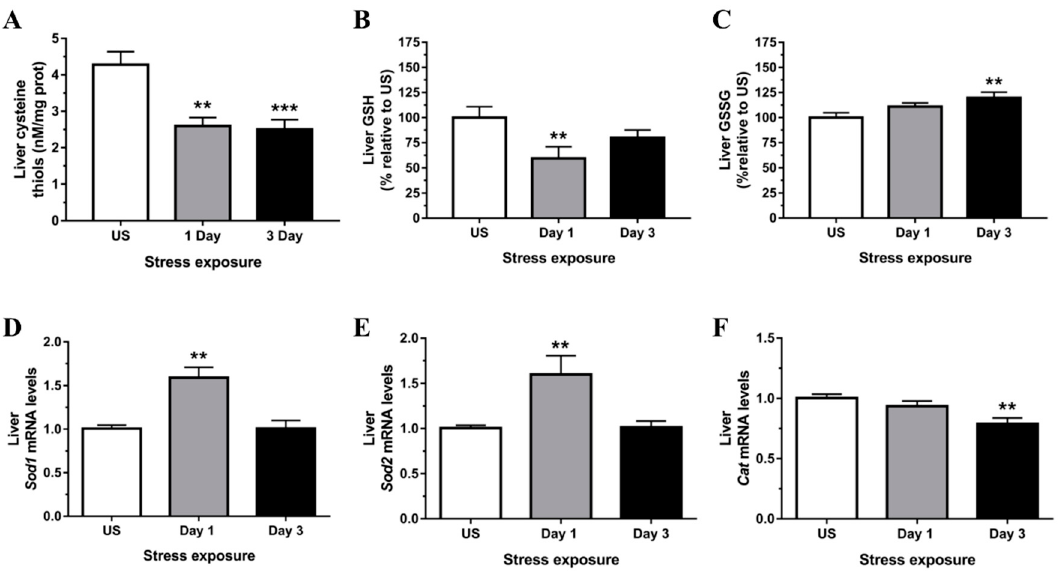
Figure 2. Restraint stress induces hepatic redox imbalance as shown by ( A ) decreased free cysteine thiol content and ( B ) decreased reduced glutathione (GSH) with increased ( C ) glutathione disulfide (GSSG). This occurs alongside increased mRNA expression of ( D ) superoxide dismutase 1 ( Sod1 ) and ( E ) superoxide dismutase 2 ( Sod2 ) but decreased ( F ) catalase ( Cat ) compared to unstressed (US) rats (n = 7–8/group). Results in ( A – C , F ) were analyzed using one-way ANOVA with Fisher’s LSD test; ( D , E ) were analyzed using non-parametric Kruskal-Wallis test with Dunn’s post-test. Data are expressed as mean ± SEM, ** p < 0.01, *** p < 0.001.